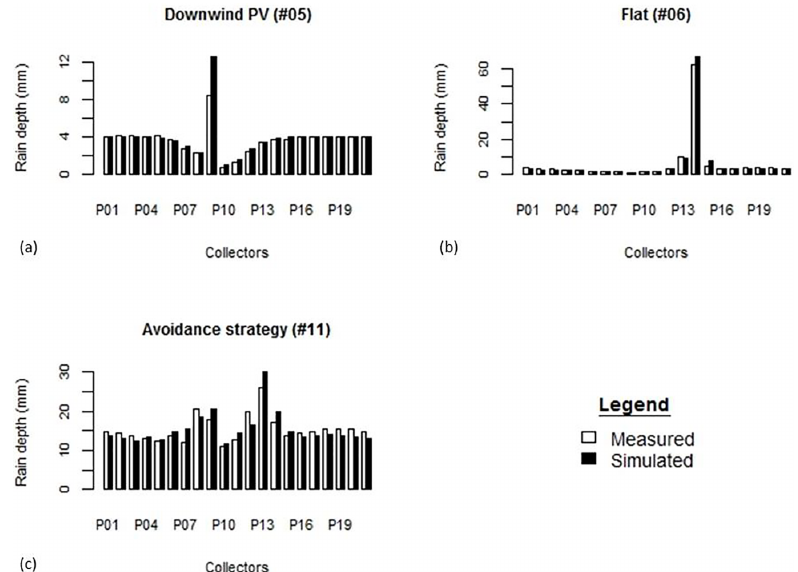
Figure 7. Examples of rain redistribution by the solar panels simulated by the AVrain model and compared to field measurements for three very different events and managements of the solar panels (see Tables 3 and 4 for details).